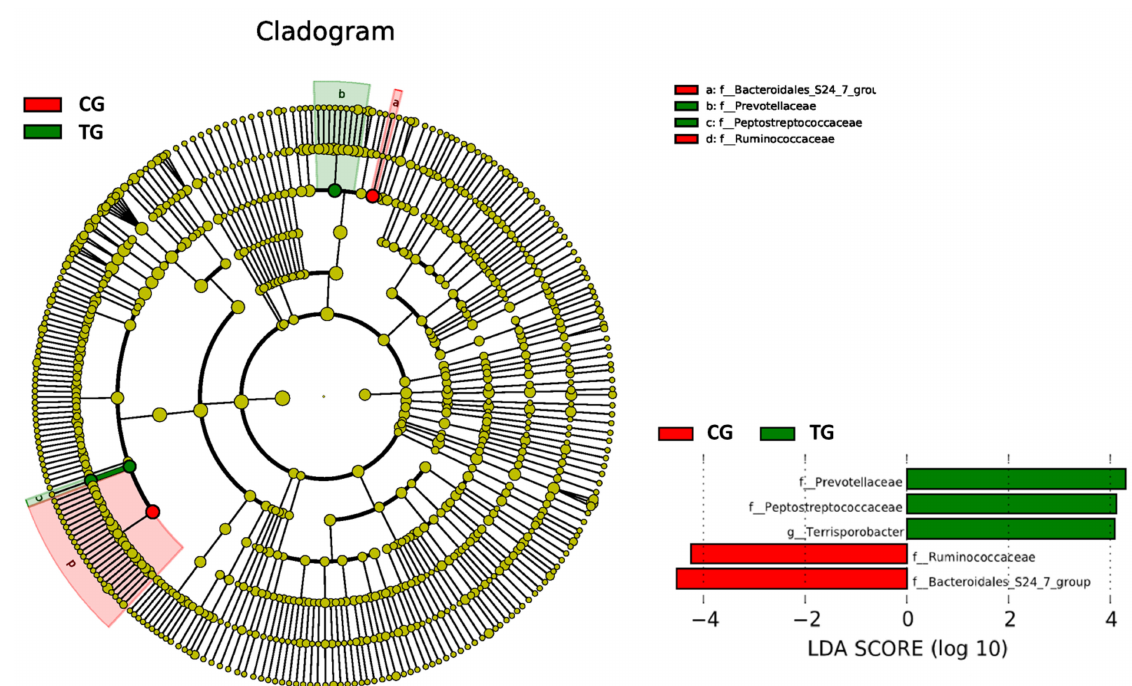
Figure 3. On the left side of the graph, differentially abundant microbial clades according to linear discriminant analysis effect size (LEfSe). On the right side, significant clades and their associated linear discriminant analysis (LDA) score for the control group (CG) and the treatment (TG) group are